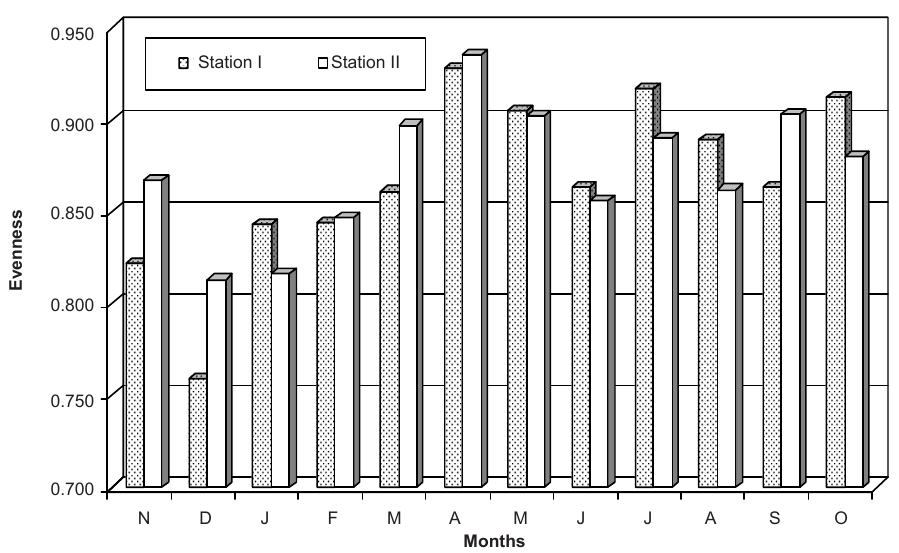
Figure 7. Monthly variations in evenness of